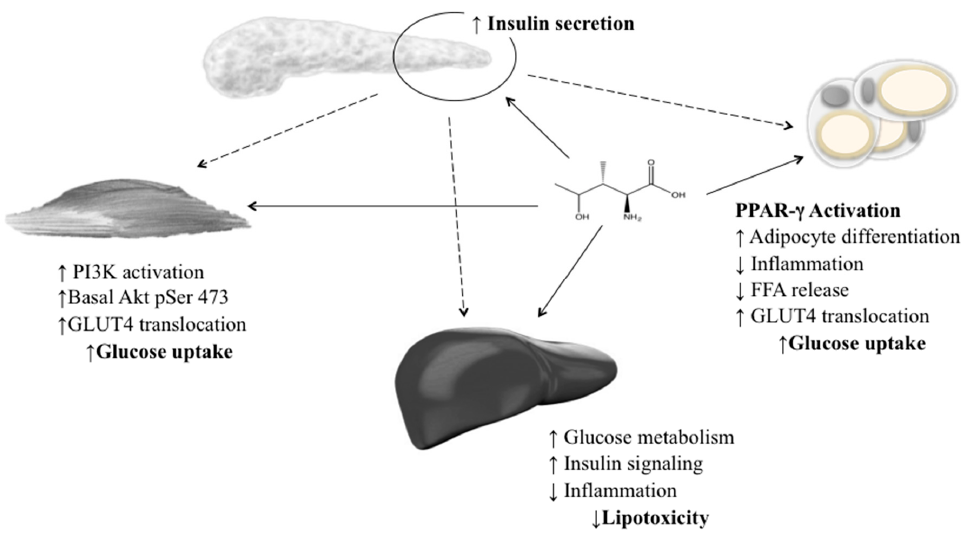
Figure 3. Insulinotropic effects of 4-hydroxyisoleucine in the pancreas, skeletal muscle, adipose tissue and liver. 4-OHIle increases insulin secretion and improves insulin sensitivity in nonadipose tissues.